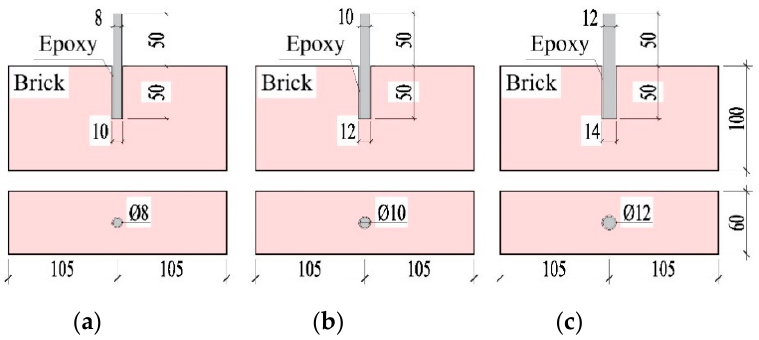
Figure 2. Bolt position and dimension on the brick. ( a ) Specimen using M8 bolt; ( b ) Specimen using M10 bolt; ( c ) Specimen using M12 bolt.